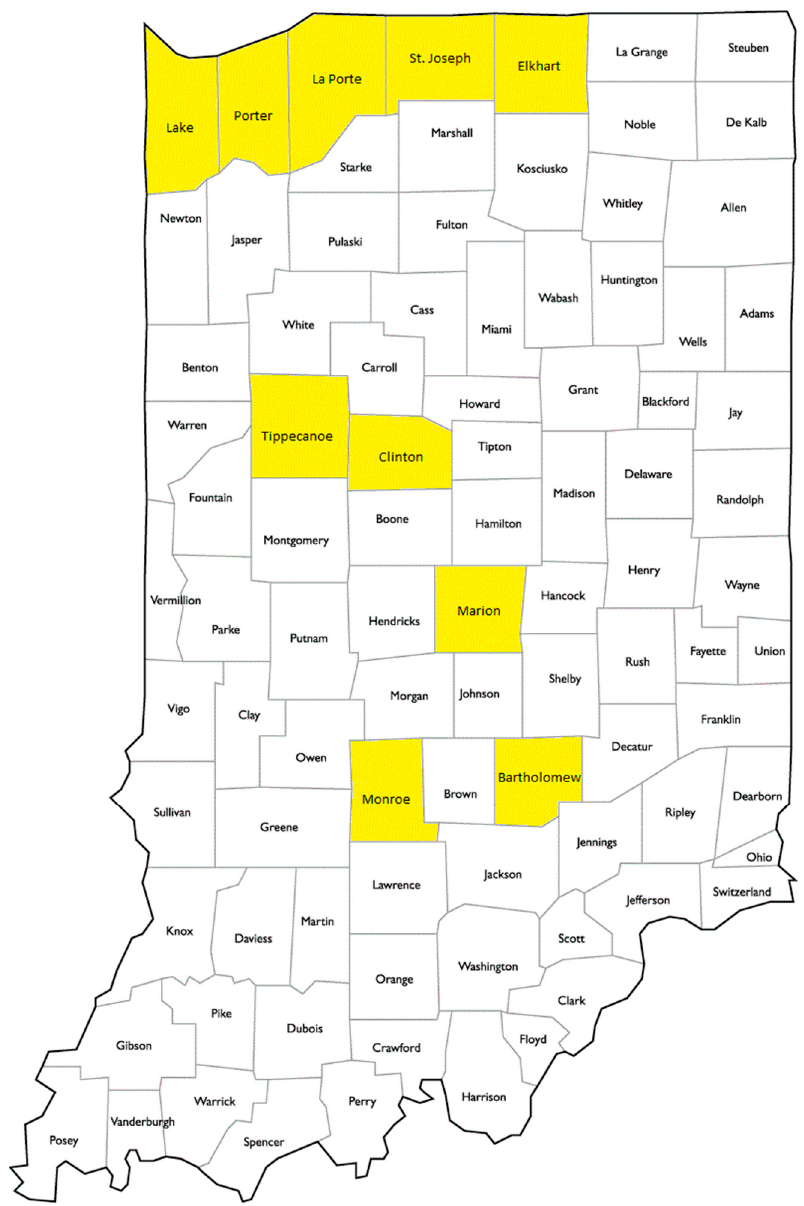
Figure A1. Recruitment counties for VidaSana in Indiana.